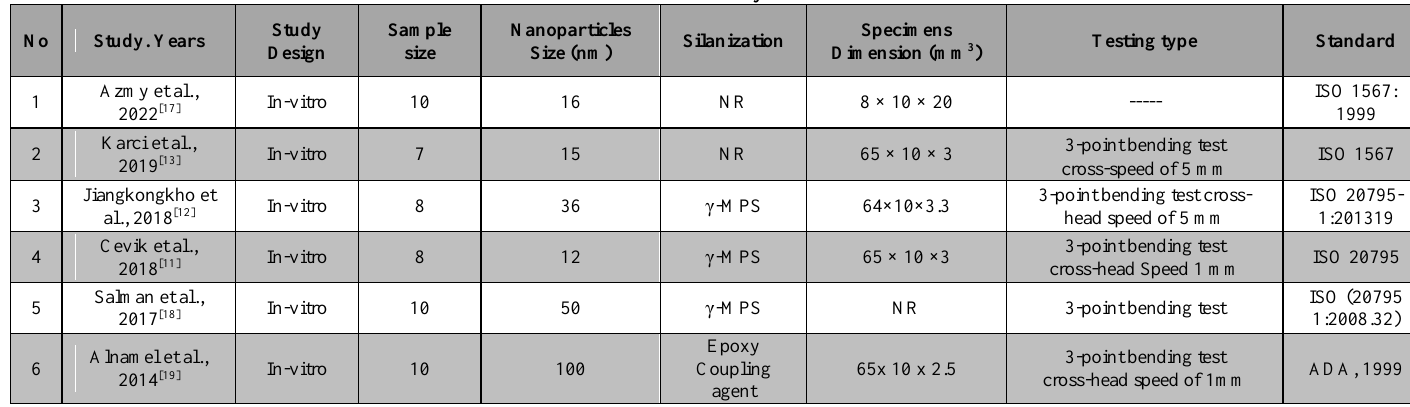
Table 2. Summary of